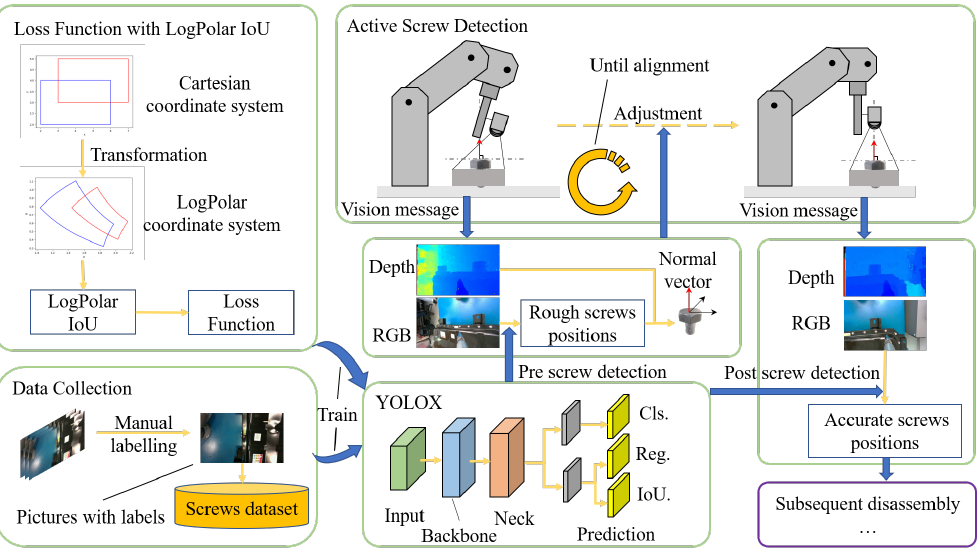
Figure 2. Framework of the “Activate Screw Detection”.